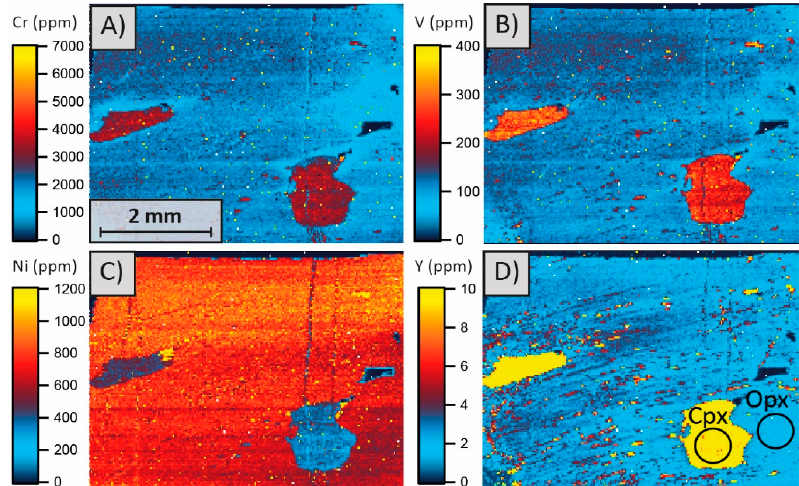
Figure 9. Semi-quantitative trace element maps of sample 309.75b, Upper Pegmatoid. ( A ) Cr-, ( B ) V-, ( C ) Ni- and ( D ) Y distribution maps. The upper boundaries of the concentration intervals were adapted to bring either orthopyroxene or clinopyroxene in the blue (lower) concentration interval and compare the colours of the second pyroxene mineral across different element maps. Thereby relative concentration differences are illustrated. The contrast in relative concentration between orthopyroxene and clinopyroxene is highest in Y compared to V and Cr (relative difference Y > V > Cr > Ni; see composition of circular ROI defined in ( D ) on Table 1), therefore Y is the best choice to exclude clinopyroxene from orthopyroxene. Table 1. Comparison of the trace element inventory between two circular ROI on clinopyroxene and orthopyroxene; locations indicated in Figure 9D). Relative concentration difference is greatest for Y compared to Cr, V and Ni.